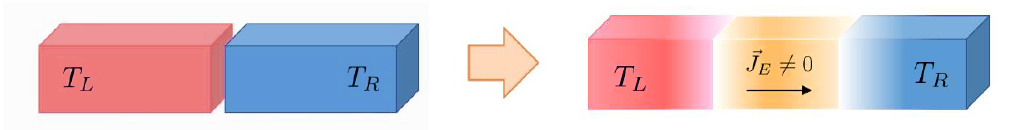
Figure 1 . At t = 0, both systems are isolated and independently at equilibrium. Evolving forward in time from t = 0, a spatially homogeneous non-equilibrium steady state develops in the middle region, carrying an energy current J E